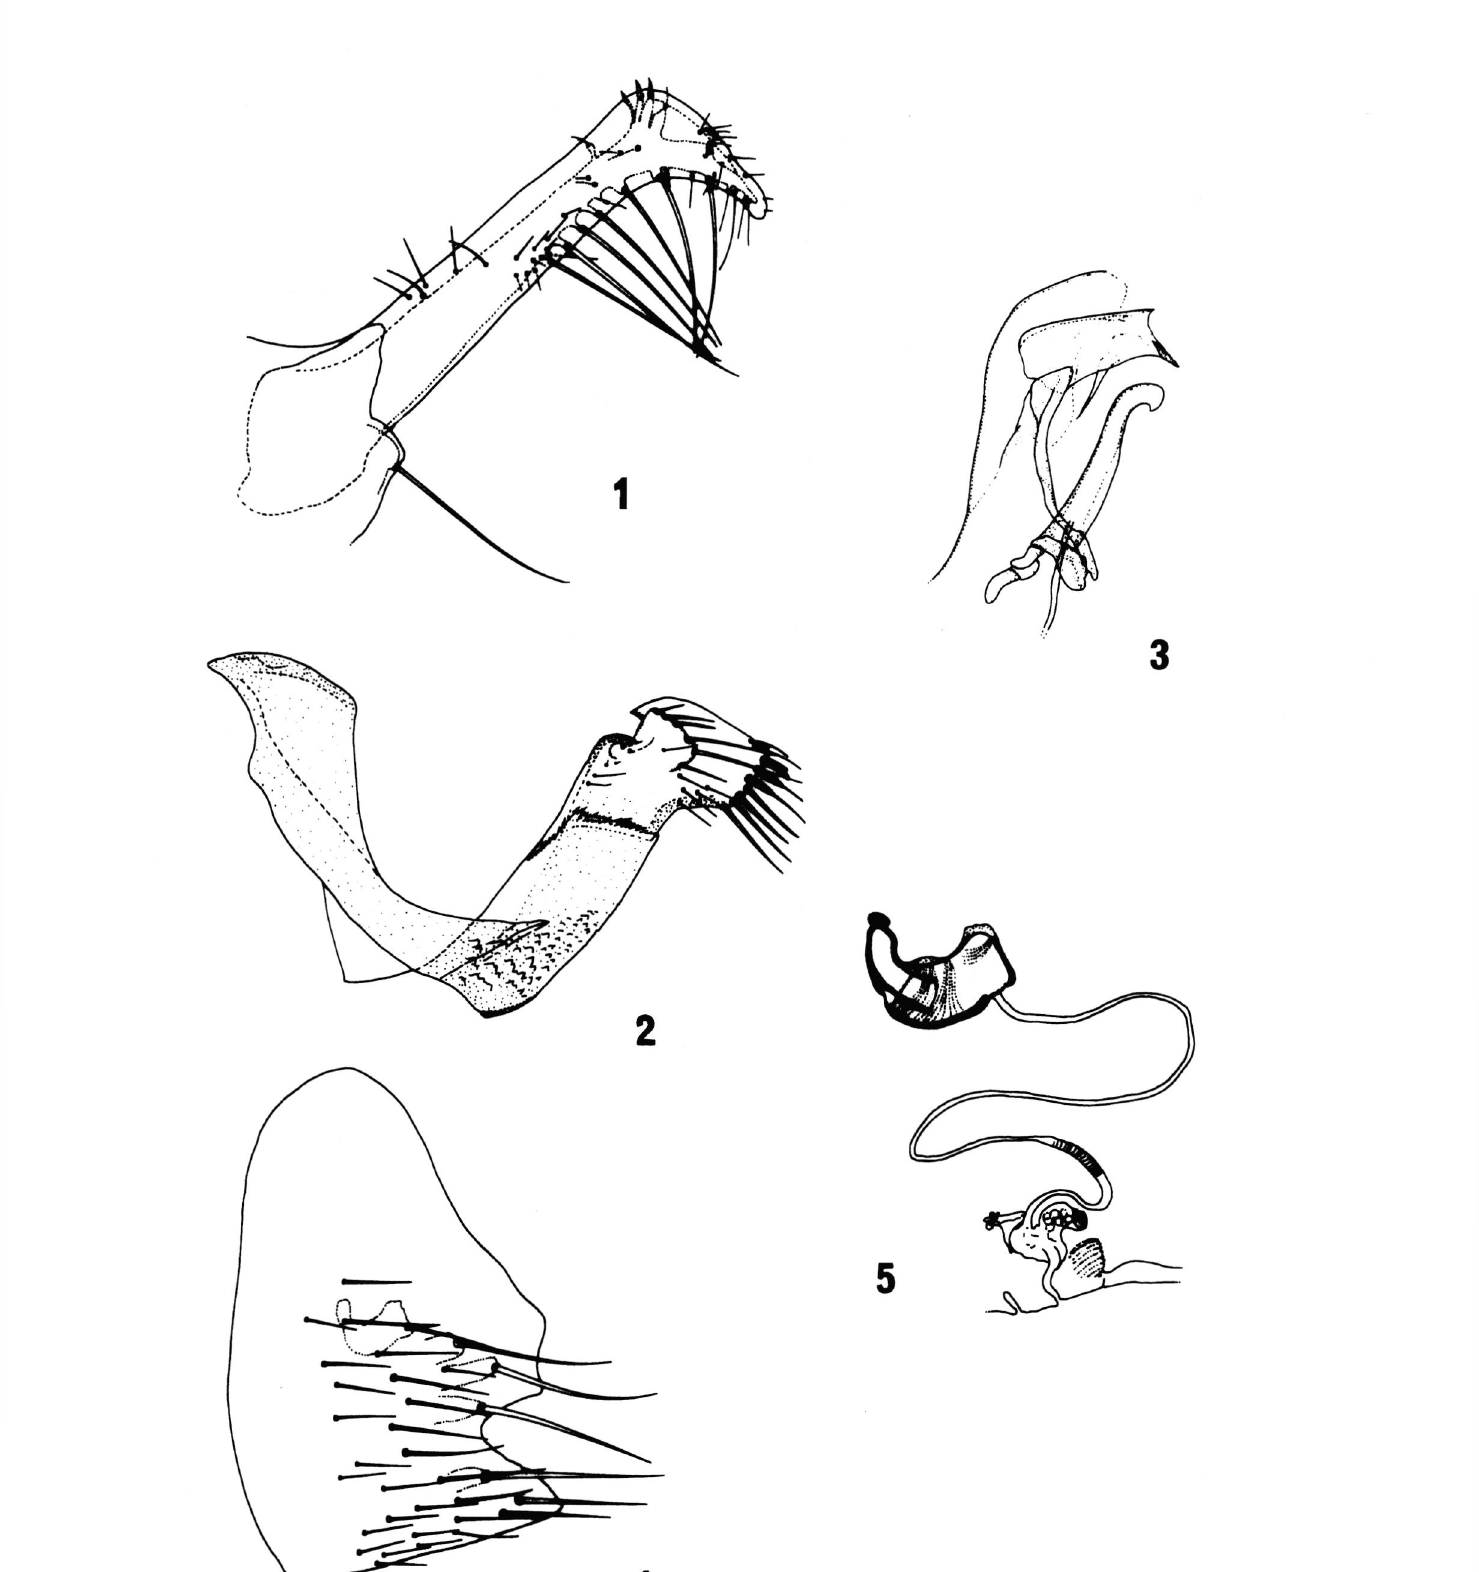
Fig. 1 à 5. - Stivalius meridionalis Durden et Beaucoumu n. sp. - 1 : tergite IX, apex du basimère et telomere (ex Rattus rattus sumbae, Indonesia, Timor, Tengah, Kesetnana, 930 m, 3 octobre 1973 [B 878731); 2 : sternite IX (ex R. r. sumbae, Timor, Tengah, Nenas (10°01' S - 124°43' E), 1360 m, 8 octobre 1973 [B 87921]); 3 : Aedeagus (Holotype - ex R. r. sumbae, Timor, Tengah, Soe (9°52' S - 124°l6' E), 890 m, 28 septembre 1973 [B 87851); 4 : sternite VII de la femelle (Allotype - mêmes références et préparation que ci-dessus); 5 ; sper- mathèque et ducti (Allotype). Parasite, 2001, 8, 147-153 Mémoire